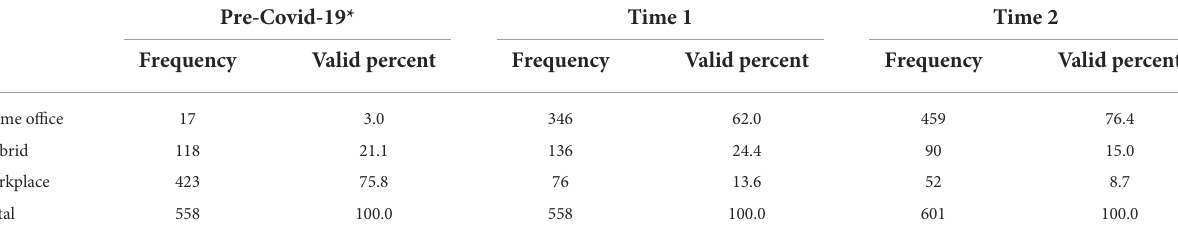
TABLE 1 Distribution of employees responding on which alternative best describes their working situation before and during (Times 1 and 2) COVID-19. Pre-Covid-19*